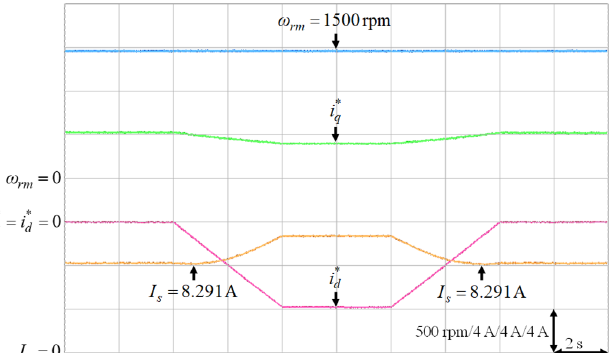
Figure 18. Experimental results of finding the lowest stator current at 1500 rpm with 6 Nm.